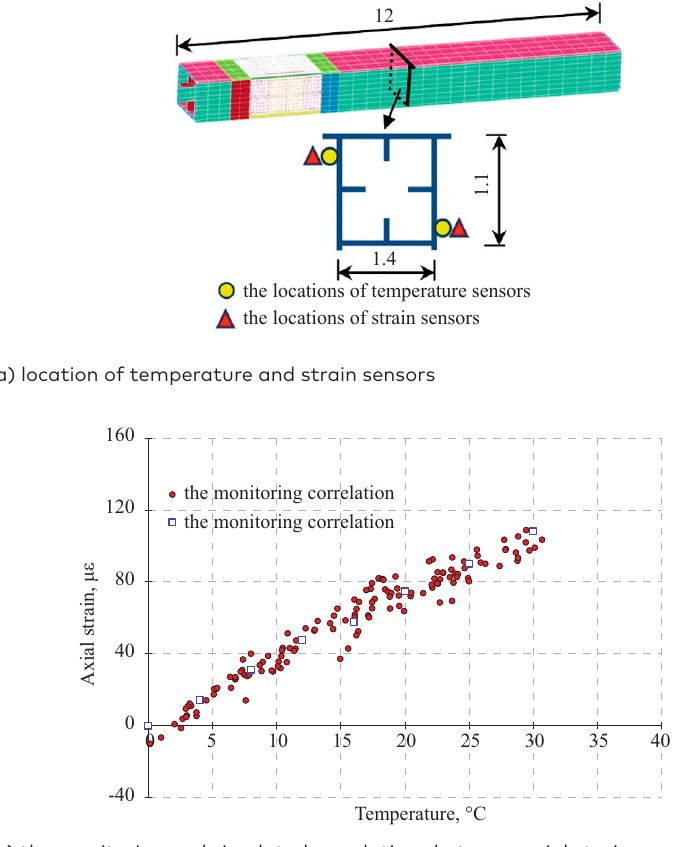
Figure 4. Validation of finite element